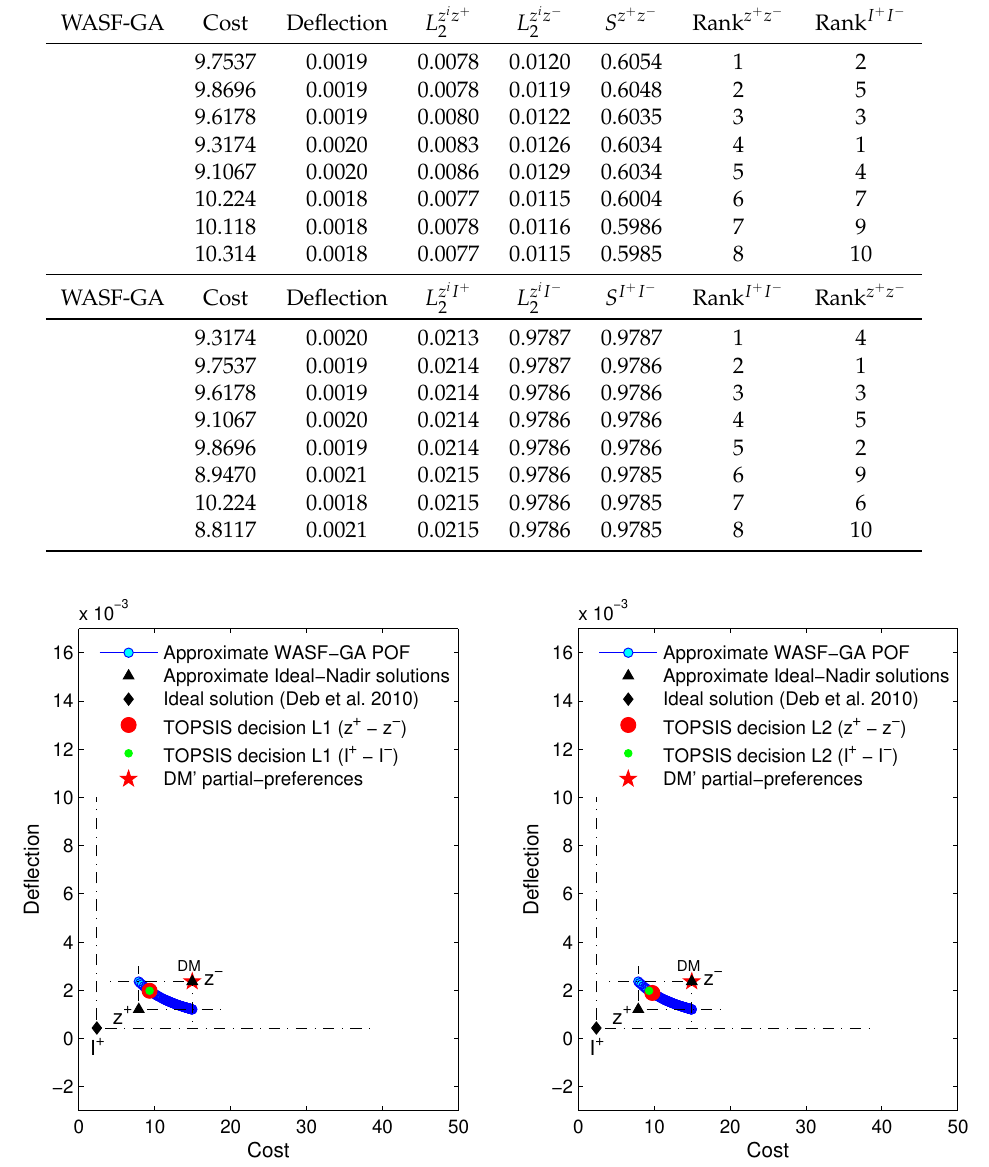
Figure 17. TOPSIS decision with L 1 ( left ) and L 2 ( right ) metrics on the approximate POF with the hypervolume indicator closest to the average value of hypervolume after 100 runs for WASF-GA, DM’s partial-preferences (15,0.0025) ( N =